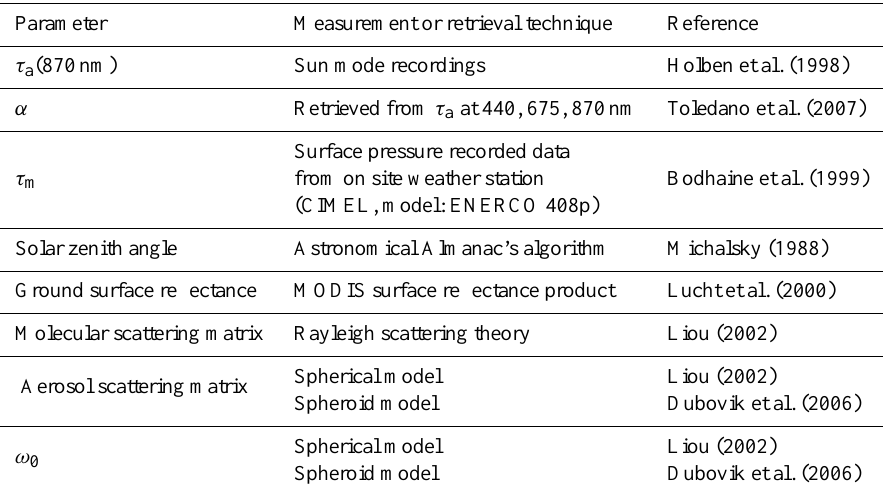
Table 1. The required parameters for solving VRTE to calculate the L and L p